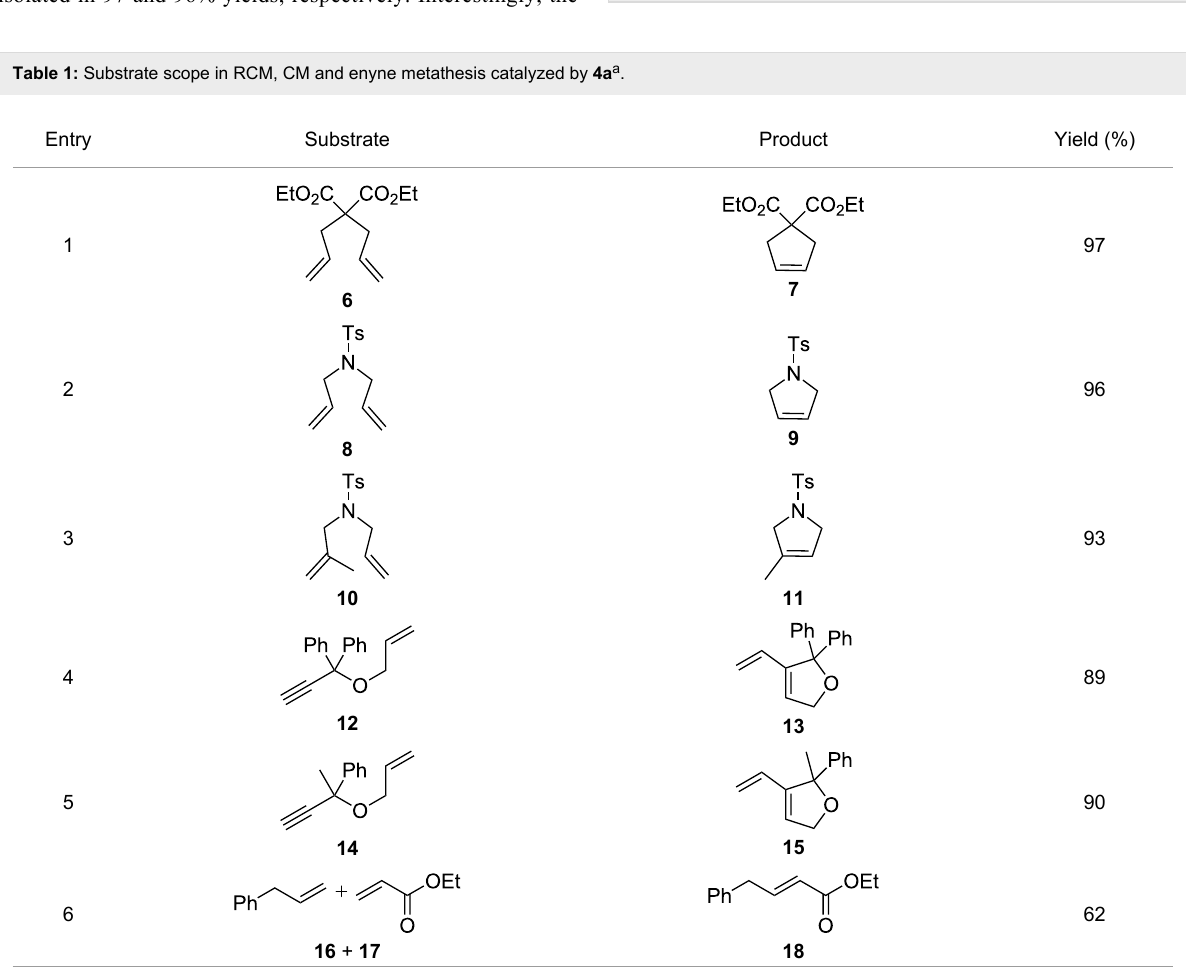
Figure 4: Influence of various acids for the activation of 4a in the RCM of